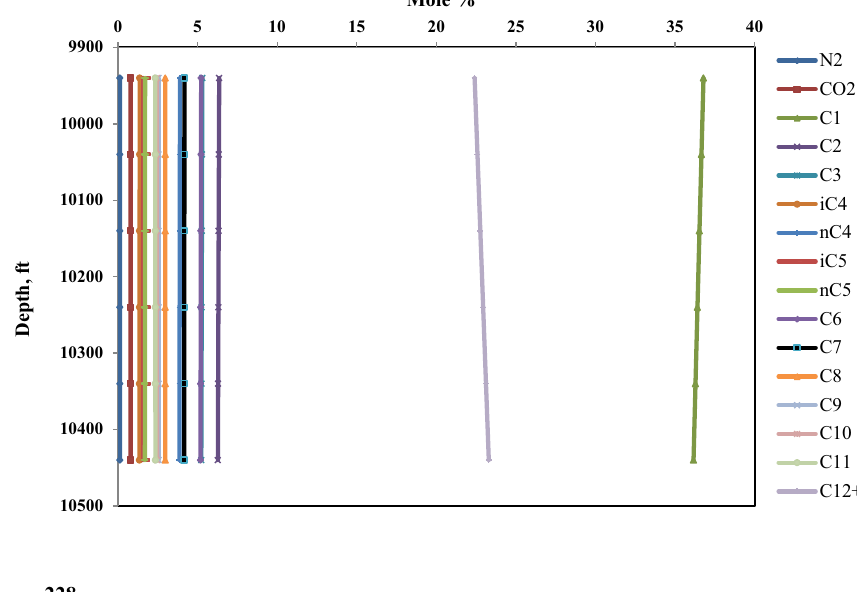
Fig. 5 Calculation of STOOIP considering the composition of fluids in different layers of the